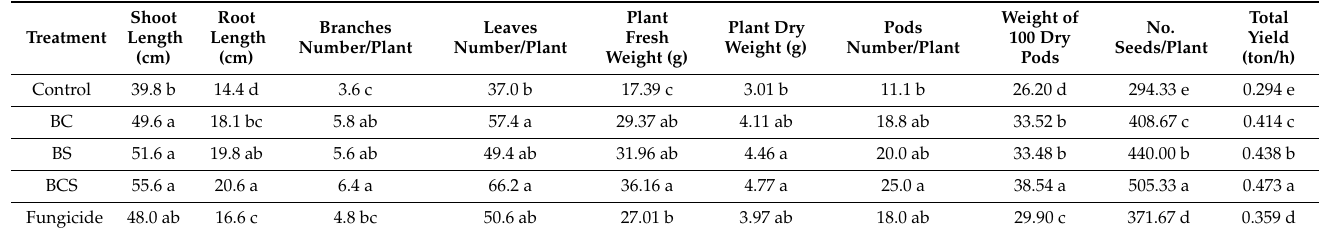
Table 7. Growth and yield of fenugreek as affected by the tested endophyte Achromobacter sp. F23KW treatments in the field under natural infection conditions.